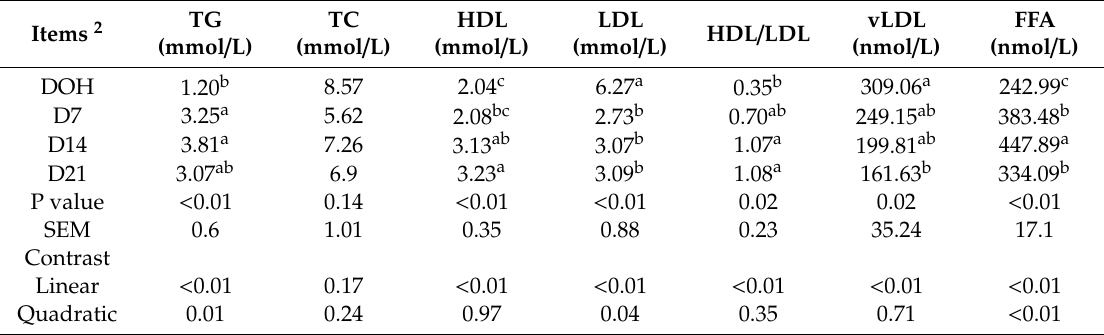
Table 3. The age-related changes in serum lipid levels of domestic pigeon squabs 1 .